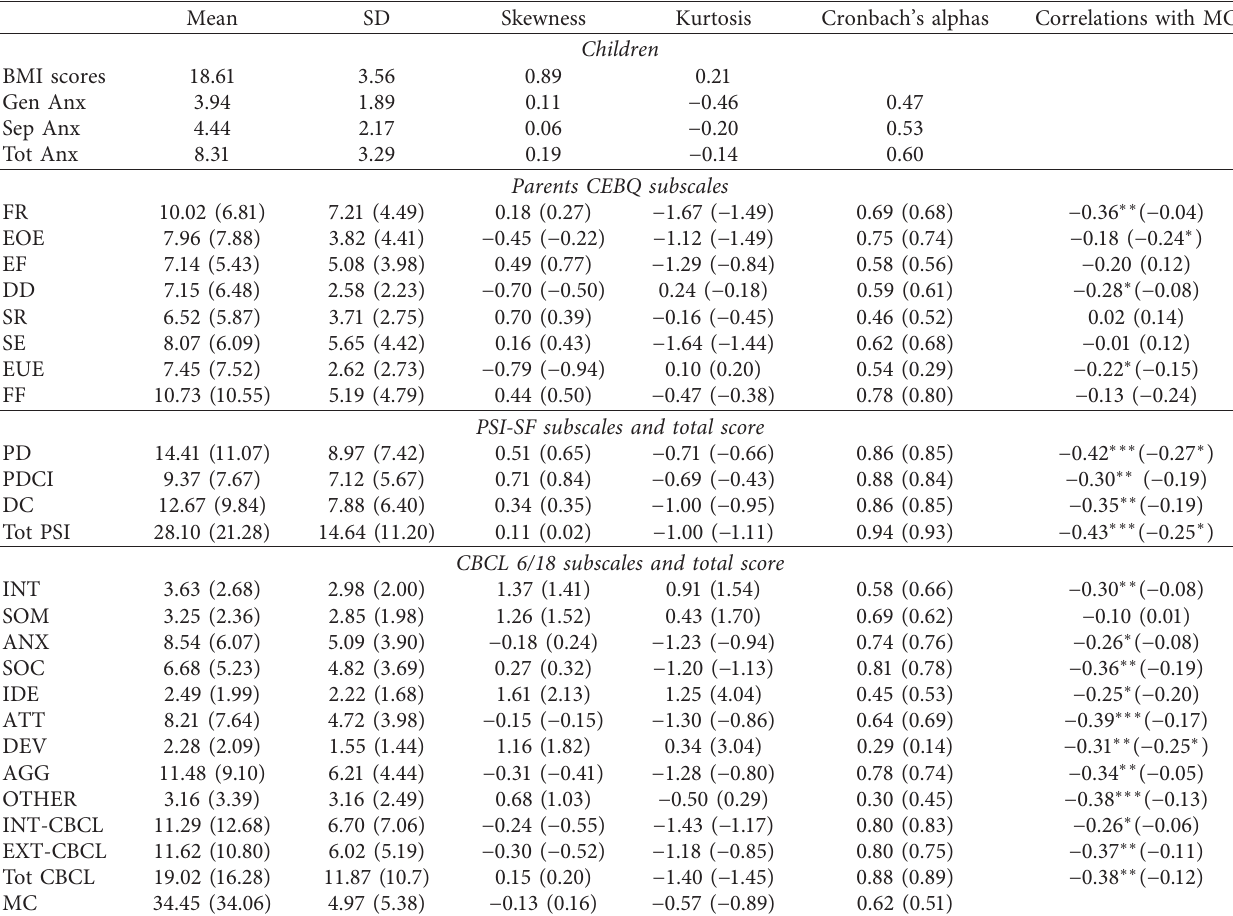
Table 3: Descriptives of quantitative data for children (BMI score, Gen Anx, Sep Anx, and Tot Anx) and of CEBQ, PSI-SF, CBCL subscales, and total scores divided for mothers and fathers. Cronbach’s alphas and bivariate correlations with MC scores are also reported. Fathers’ values are reported in